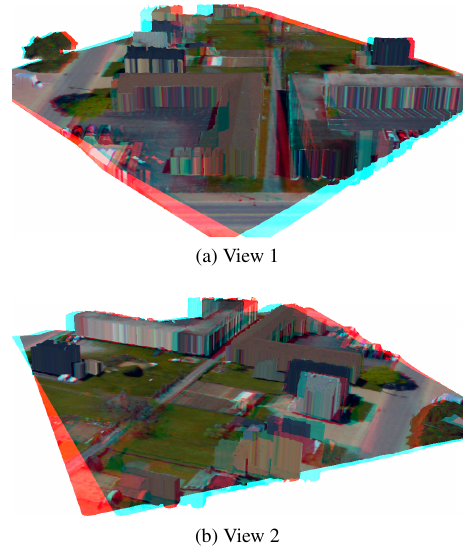
Figure 8: Anaglyph views of the